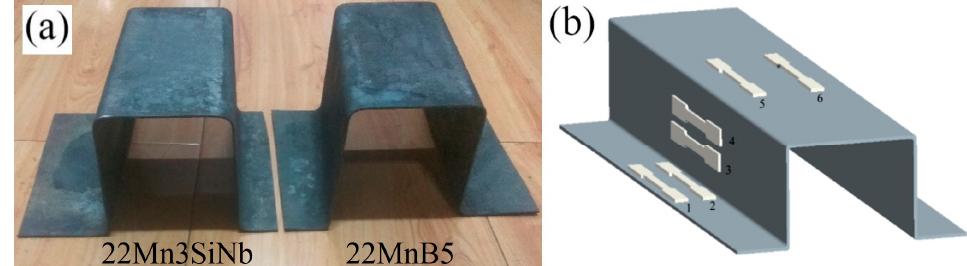
Figure 21. The U-shaped parts and sample location diagram. ( a ) U-channel parts, ( b ) sample Figure 21. The U ‐ shaped parts and sample location diagram. ( a ) U ‐ channel parts, ( b ) sample location.